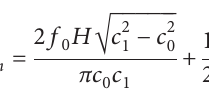
Figure 11: (a) Normalized | p 2 | field of a unit point source. (b) Normalized acoustic intensity field of the unit point source (left: I ∗ Q ∗ | p 2 | field of the cylindrical shell. (d) Normalized acoustic intensity field of the cylindrical shell (left: I ∗ z ). (c) Normalized � ( h U � 20m and f 0